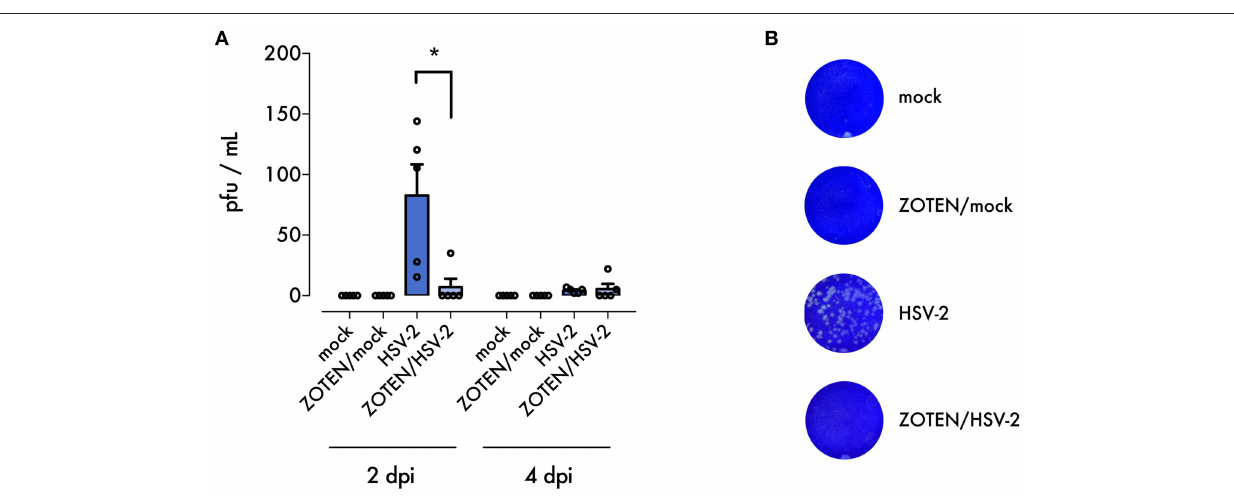
FIGURE 2 | ZOTEN treatment reduces viral shedding. (A) Plaque assay results from vaginal swabs at 2 and 4 dpi. Error bars indicate SEM ( n = 5 per group). Asterisk denotes significant difference by two-tailed unpaired Student’s t -test, * p < 0.05, ns, or unlabeled, not significant. (B) Representative images of crystal violet stained plaque assay results. Zones of clearing are noted in samples from untreated HSV-2 infected mice, indicating presence of replicating virus. following genital infection with the 4 groups mentioned